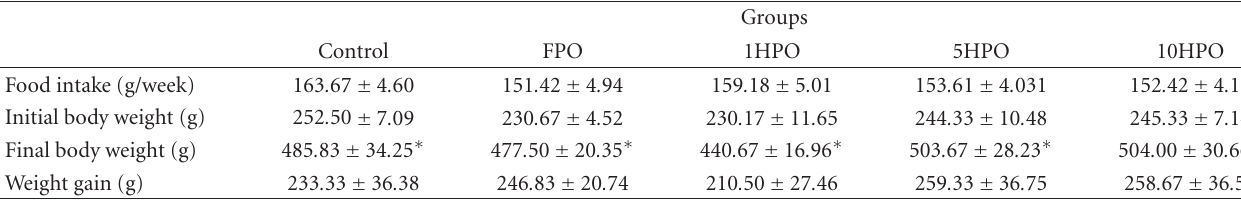
Table 1: Body weight and food intake for all the experimental groups.